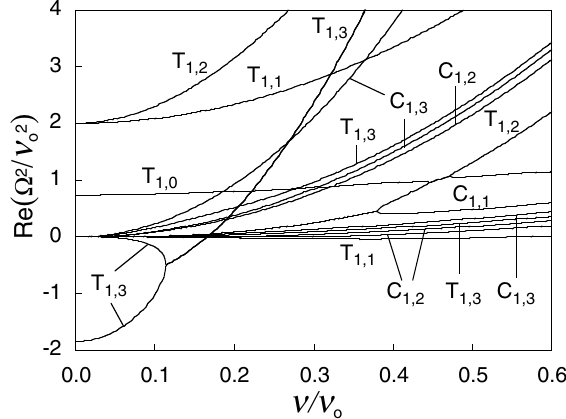
for the o for k (cid:3) 0 and FIG. 5. The real part of (cid:13) 2 =(cid:10) 2 o (cid:2) are a function of (cid:10)=(cid:10) o